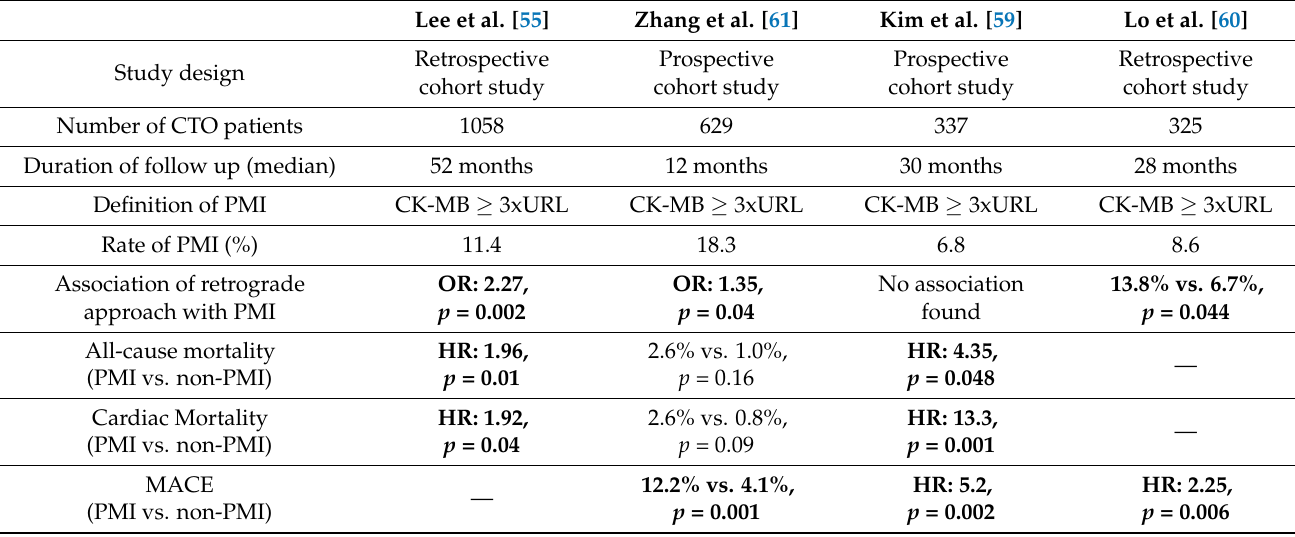
Table 2. Studies with negative prognostic impact of CTO-PCI related to previously defined PMI. Lee et al. [55] Zhang et al. [61] Kim et al. [59] Lo et al.